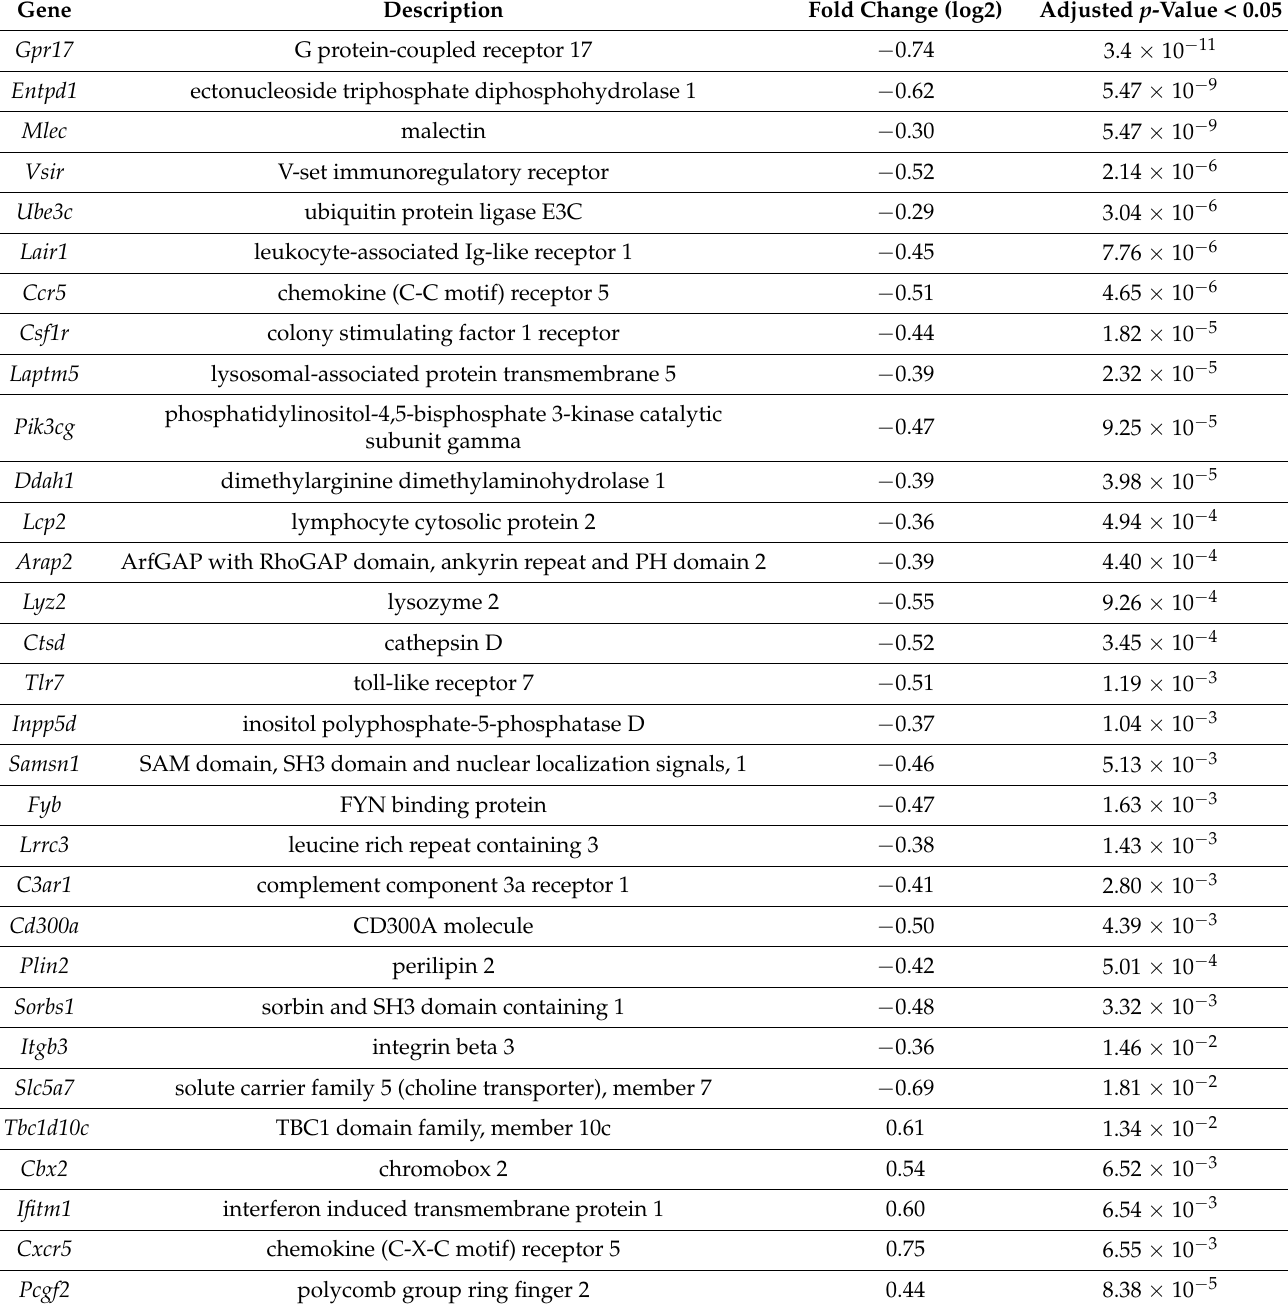
Table 4. Significantly differentially expressed genes related to T-cells and adaptive